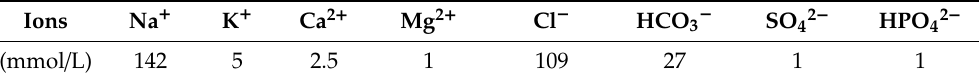
Table 1. Ion composition of simulated body fluid (SBF27; data from